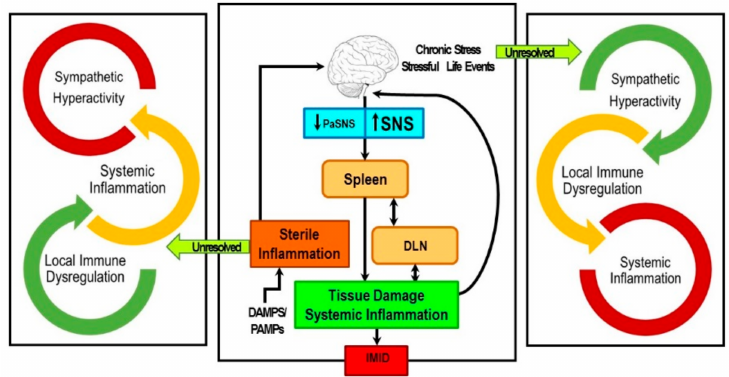
Figure 2. Chronic stress and/or stressful adverse life events chronically elevate sympathetic nervous system (SNS) activity and reactivity that can induce low grade local and systemic inflammation. Conversely, activation of the immune system by sterile inflammagens (danger-associated